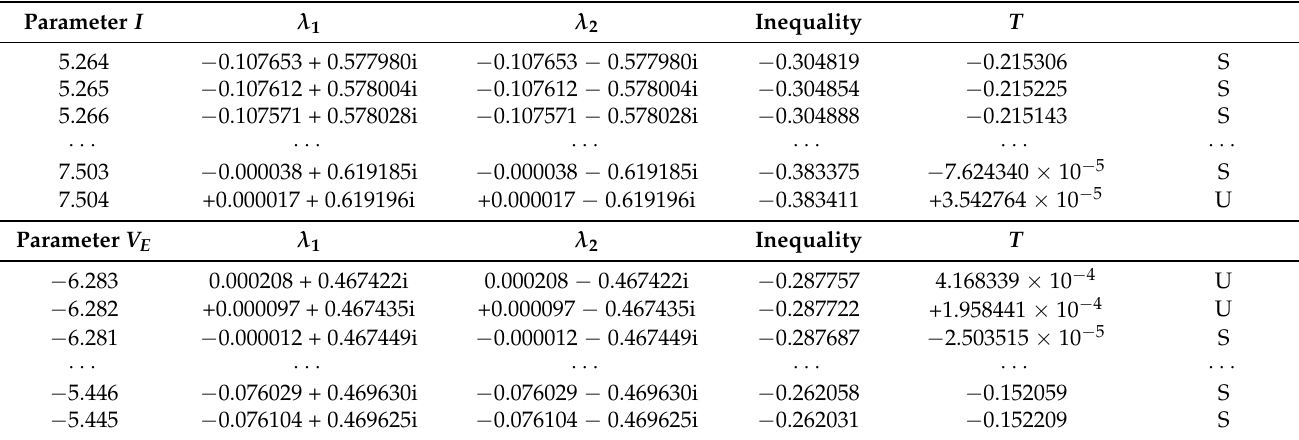
Table 1. Eigenvalues of the Jacobian, quadratic inequality, and T